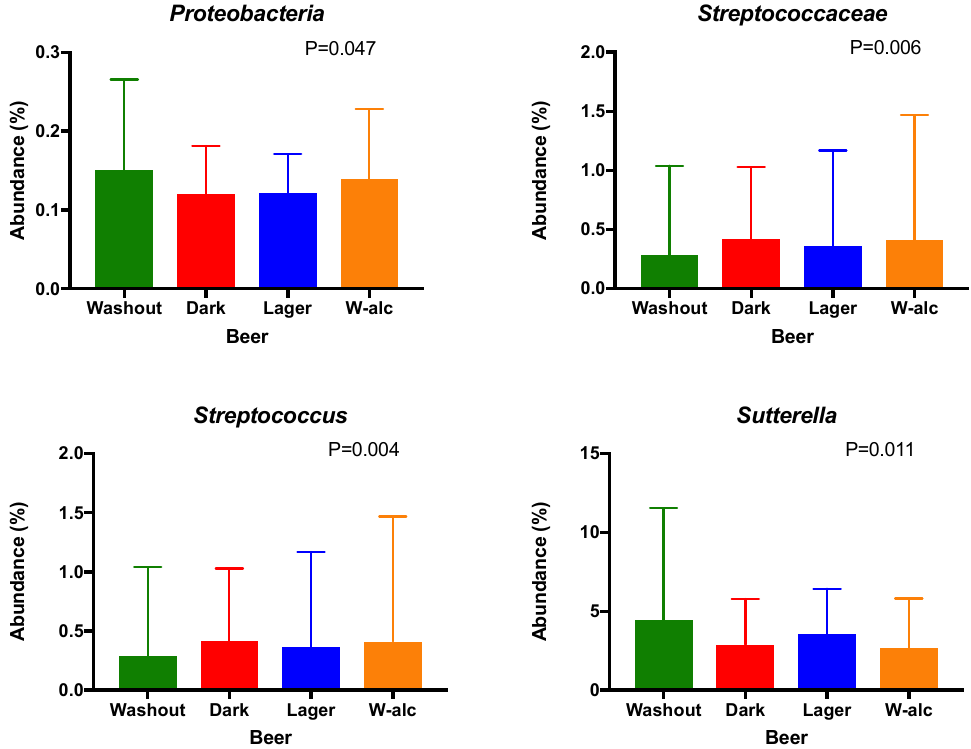
Figure 3. Taxa that significantly changed between the different intervention periods at different taxonomic levels: phylum, family and genus (DesSeq2 test; p < 0.05). Values are presented as mean ± SD (standard deviation).